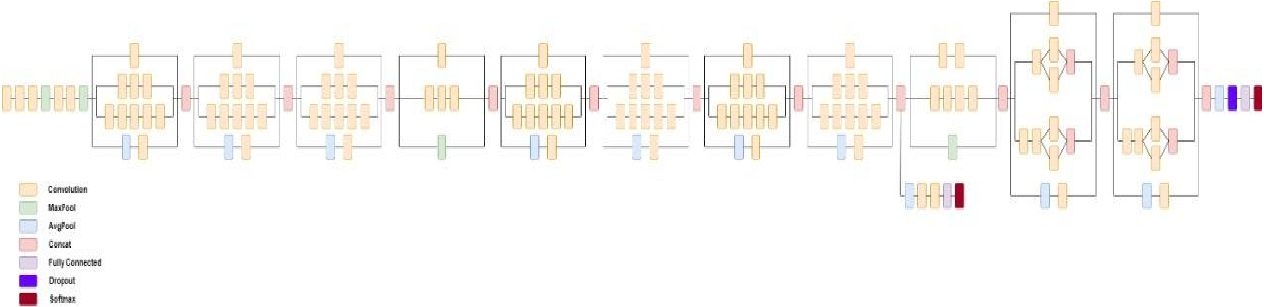
Figure 6. Architecture of InceptionV3 model.